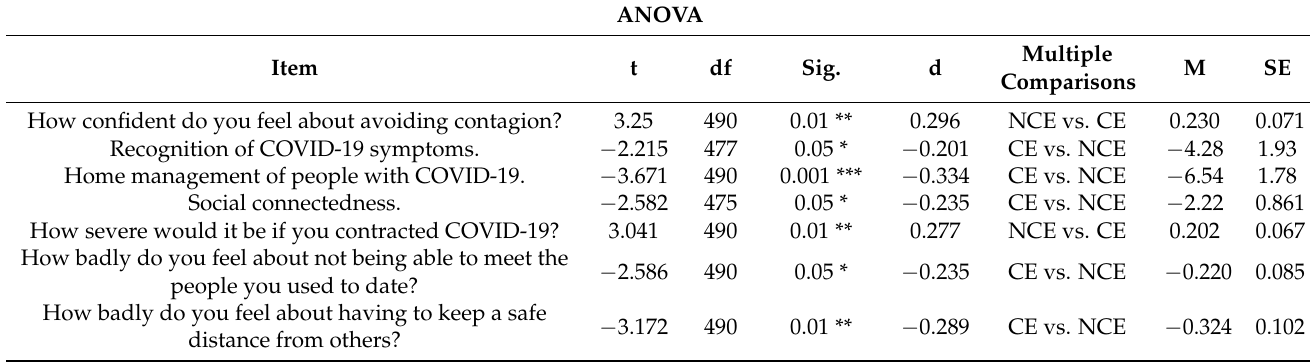
Table 2. Comparison between groups (ANOVAs). ANOVA Item Sig.